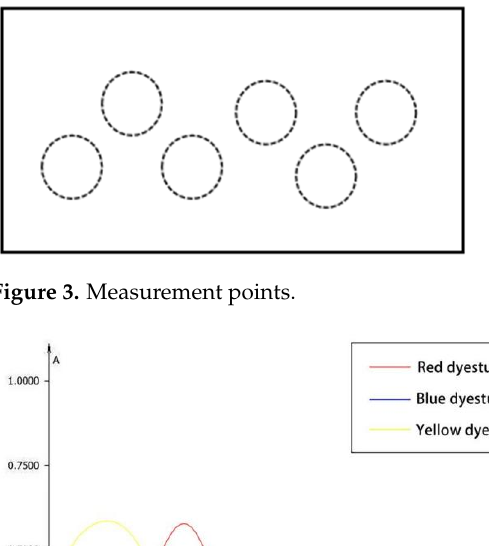
Figure 3. Measurement points.